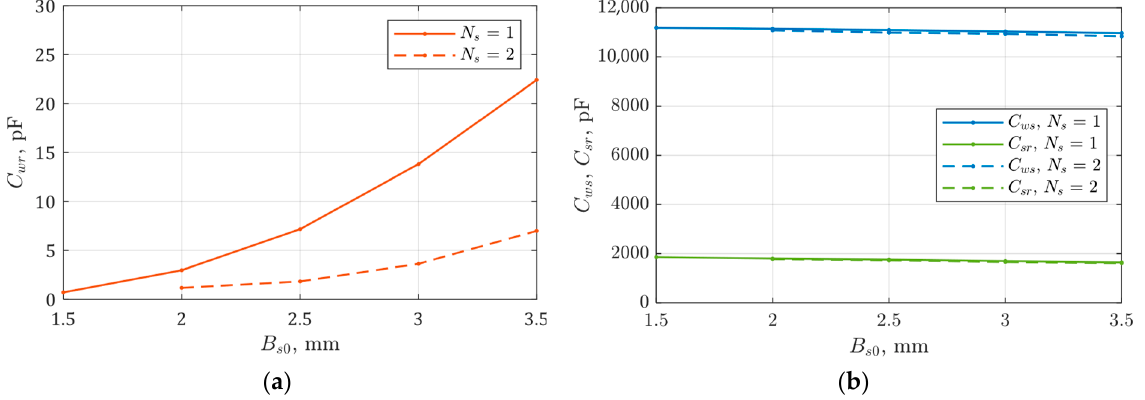
Figure 13. Characteristics of capacitance changes: ( a ) C wr , ( b ) C ws and C sr depending on the slot opening width B s0 and the number of grounded shielding wires ( ε r = 1).